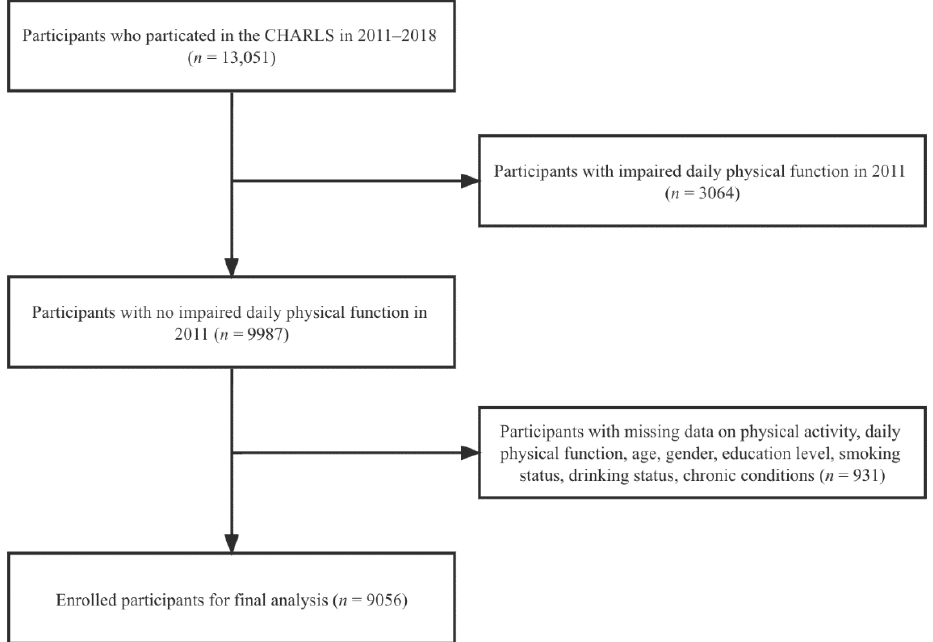
Figure 1. Flowchart of study